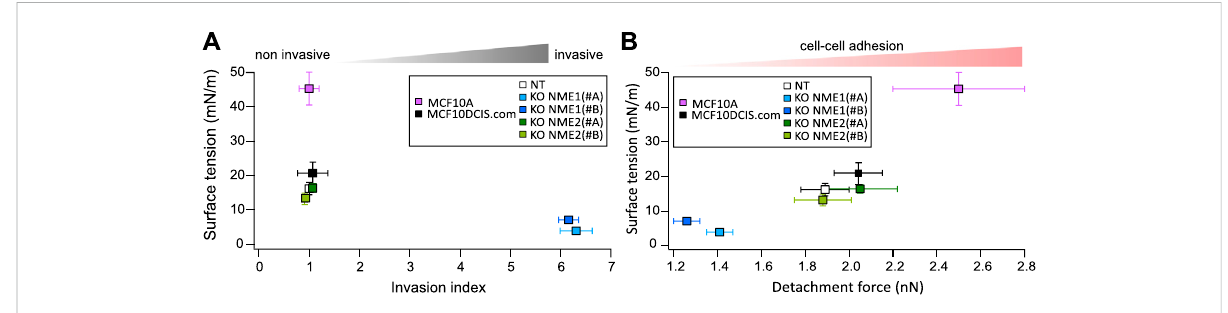
FIGURE 7 Surface tension comparison with invasion and adhesion. (A) The results obtained for the surface tension of aggregates from normal-like cells (MCF10A) and tumoral cells (MCF10DCIS.com and derivatives) are reported as a function of their invasion index. Means are indicated, and error bars show theSEM. (B) The results obtained for thesurfacetension of aggregates from normal-likecells and tumoral cells are reported inrelation to their adhesion forcemeasuredbyAFMafter a60 scontact. MCF10Aadhesion forceisextracted fromPawlizaketal. (2015).Meansare indicated,and error bars show the